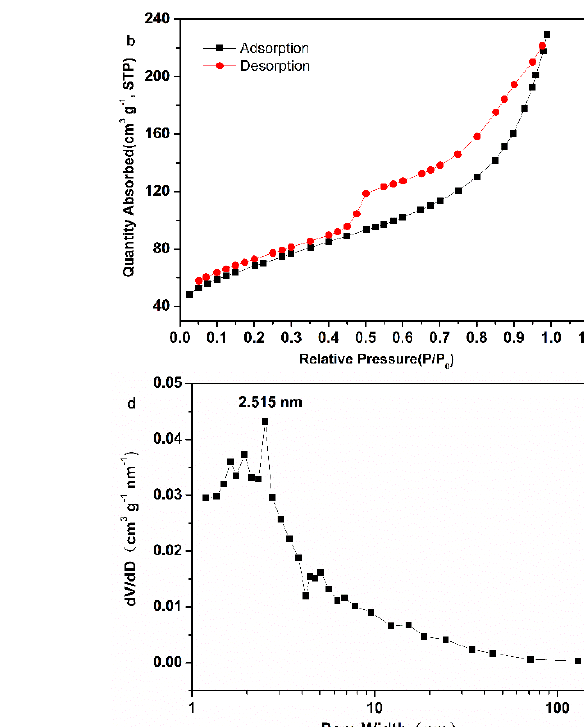
Figure 4. The FESEM image of FeOOH-GA 0.25 ( a ) and corresponding element mapping images of C ( b ), O ( c ), Fe ( d ) and S ( e ).